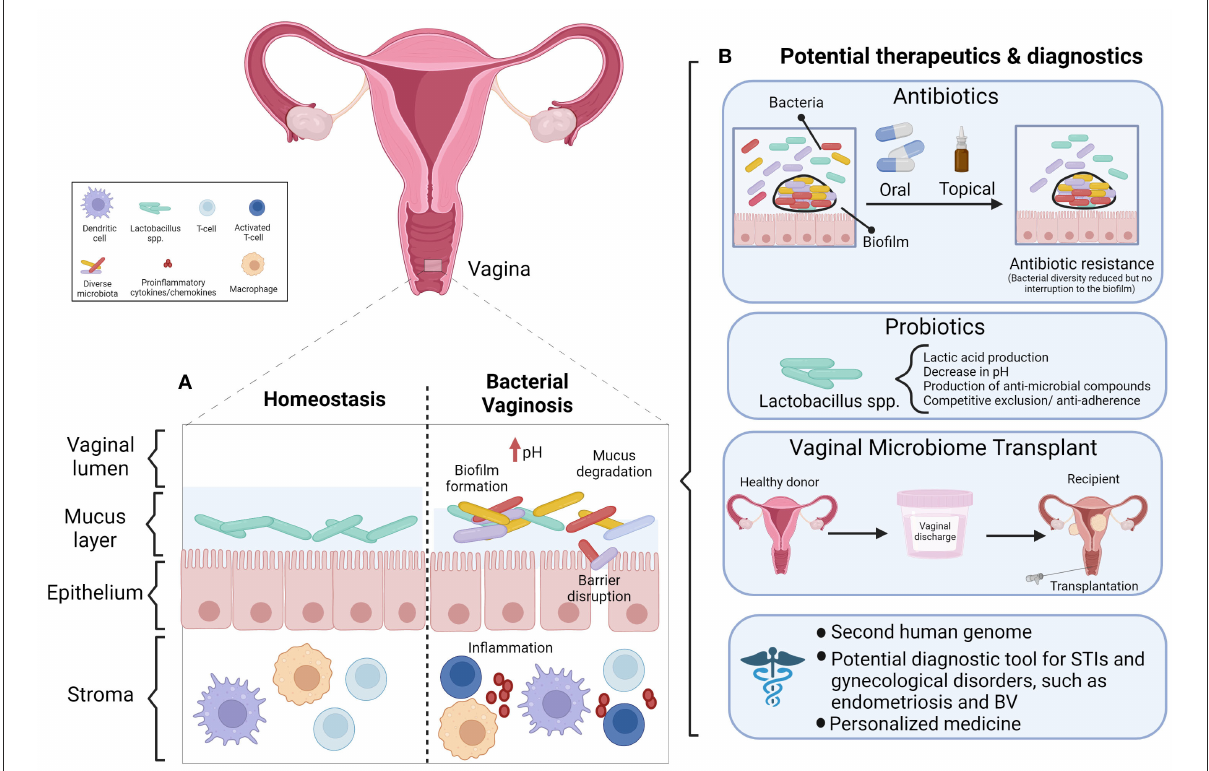
FIGURE3 Summary of the female reproductive tract microbiota, inflammation, and therapeutics and diagnostics. (A) An illustration depicting a summary of the vaginal microbiota in homeostasis vs. a dysbiotic state (as in Bacterial vaginosis). In homeostasis, the native bacteria are tolerated by the host immune system, while in a dysbiotic state the bacteria and/or metabolites induce an immune response and inflammation in the host. Barrier disruption can occur as a result. (B) An overview of how the female reproductive microbiotas might be harnessed as potential therapeutics and diagnostics for gynecological conditions involving inflammation and/or dysbiosis in the female reproductive tract. BV, Bacterial vaginosis; STI, sexually transmitted infections. Created with